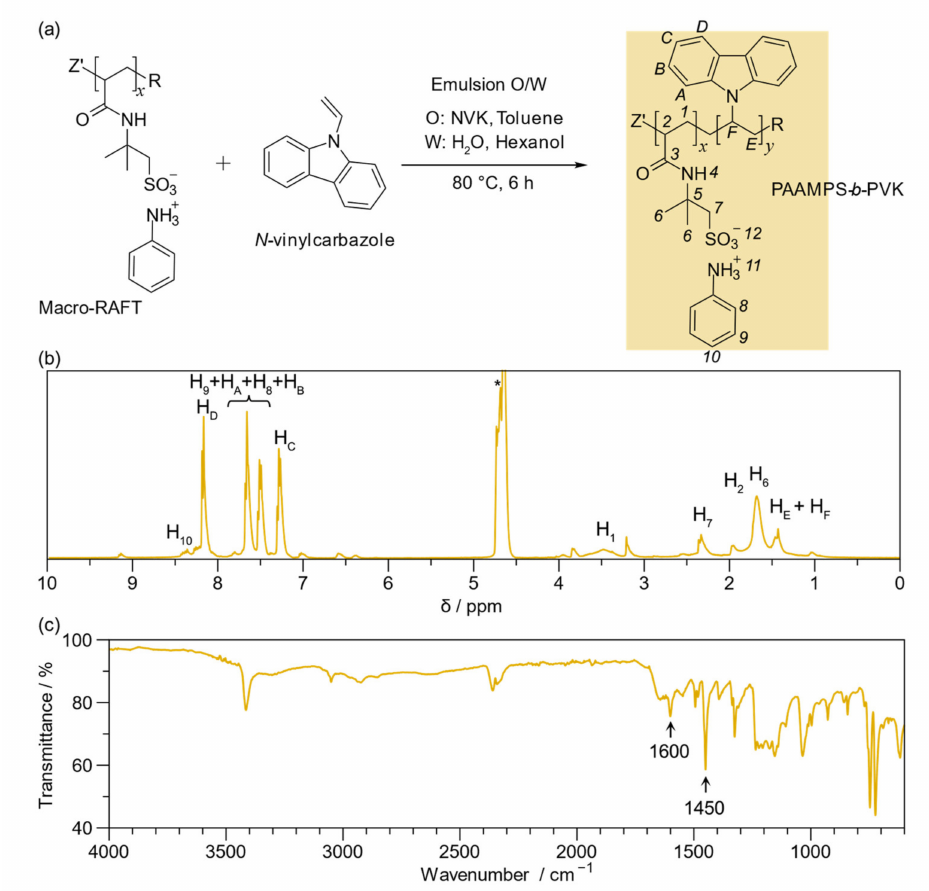
Figure 3. ( a ) RAFT-mediated surfactant-free emulsion polymerization scheme of N -vinylcarbazole (NVK) and proton assignment (yellow shaded area); ( b ) 1 H NMR spectrum of poly(anilinium 2-acrylamide-2-methyl-1-propanesulfonate)- block -Poly( N -vinylcarbazole) PAAMP- b -PVK [1.0:1.5], * solvent: THF/water mixture; ( c ) FT-IR spectrum of PAAMP- b -PVK